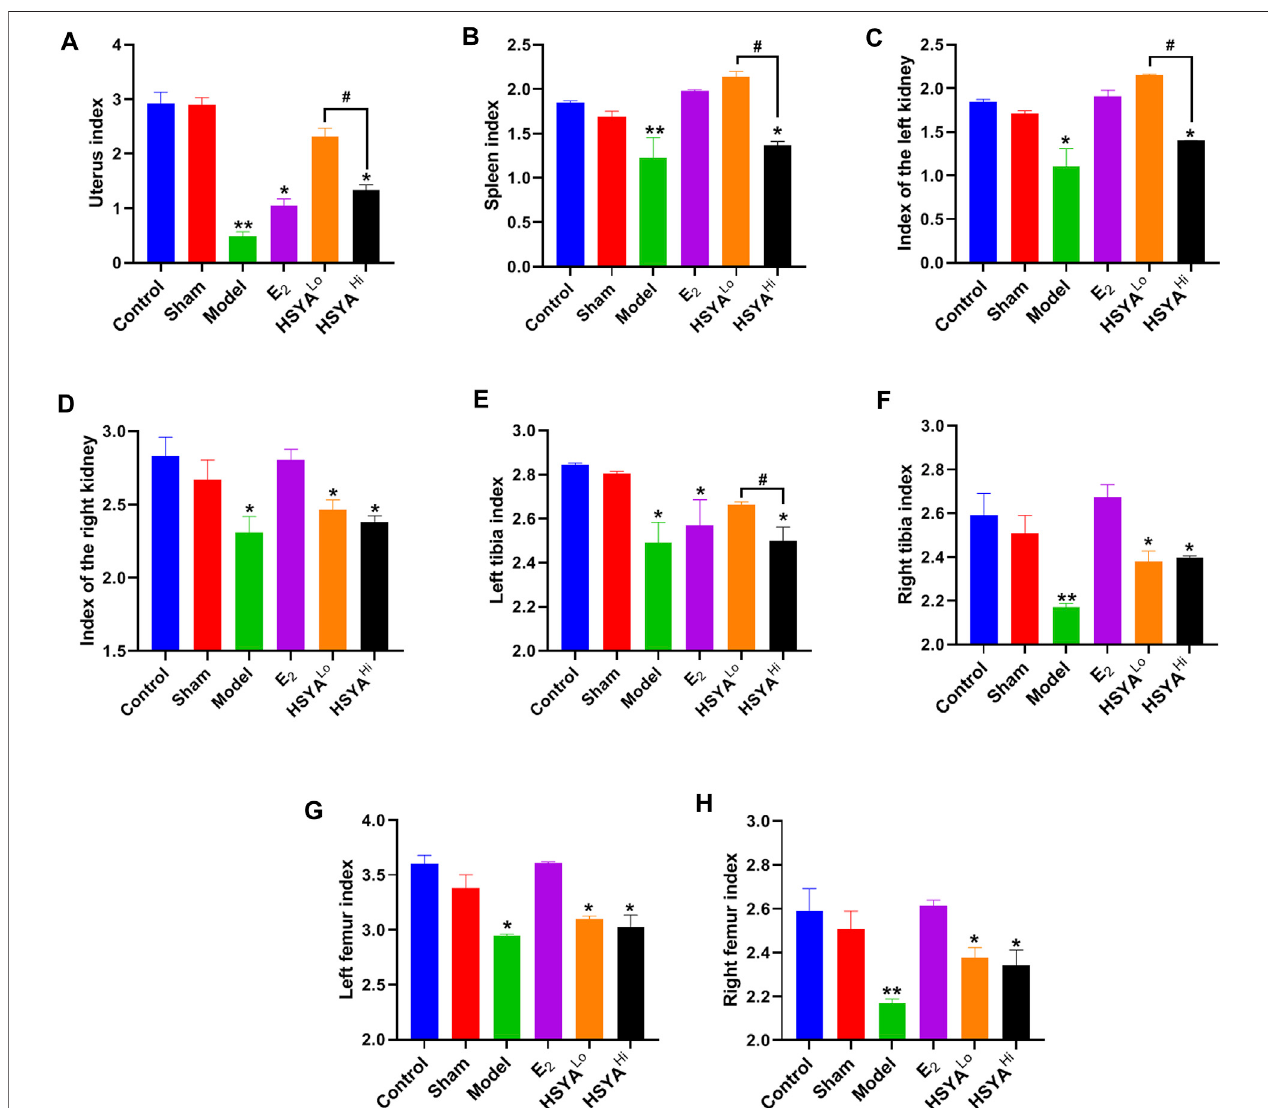
FIGURE2| Indexofvarious organs inrats. (A) ratuterine index. (B) ratspleenindex. (C) ratleftkidneyindex. (D) ratright kidney index. (E) ratleft legtibia index. (F) rat right leg tibia index. (G) rat left leg femur index. (H) rat right leg femur index. “ ** ” indicates p < 0.01, “ * ” indicates p < 0.05, compared with the control group, the difference is statistically signi fi cant. “ # ” indicates p < 0.05, and the difference was statistically signi fi cant when compared with the HSYA group.